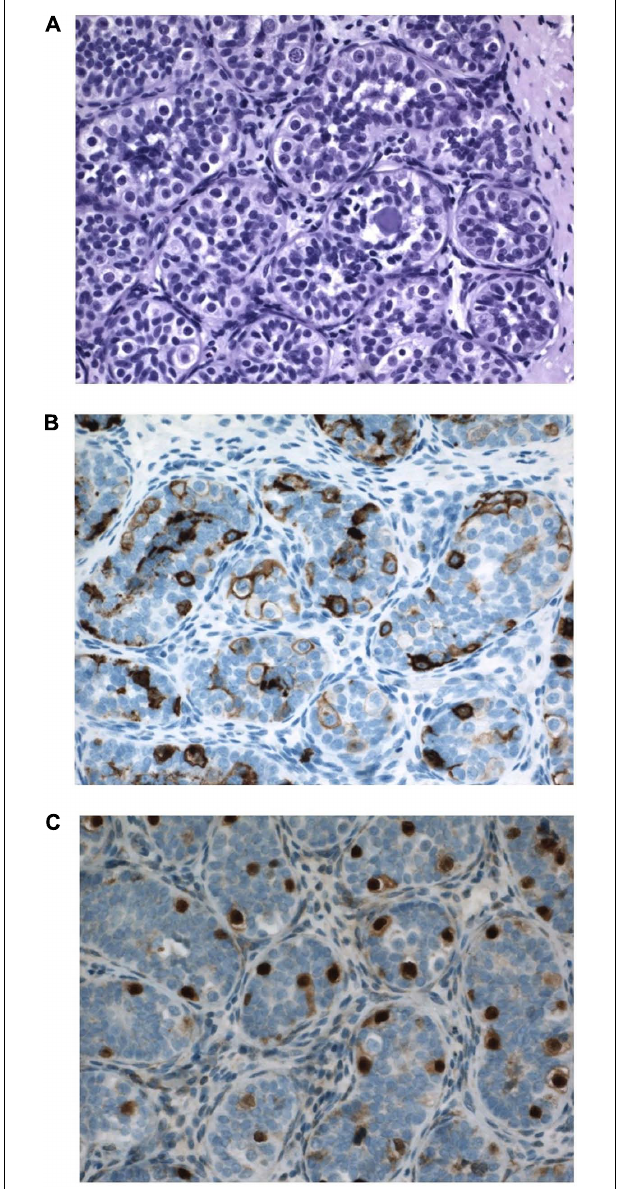
FIGURE 7 |Testicular tissue from a 12-month-old boy with bilateral cryptorchidism. Carcinoma in situ (CIS) is suspected. (A) H&E staining: Sertoli cells are normal and the germ cell number is at the upper range for age. Some germ cells have two nuclei, and some nuclei have irregular morphology and some nucleolus. A microlith is clearly seen within a tubule. (B) Strong PLAP expression seen in all germ cells. (C) OCT4 expression in germ cells also in the periphery of tubules, which is not often seen so impressively in most cryptorchid testes at a similar age.